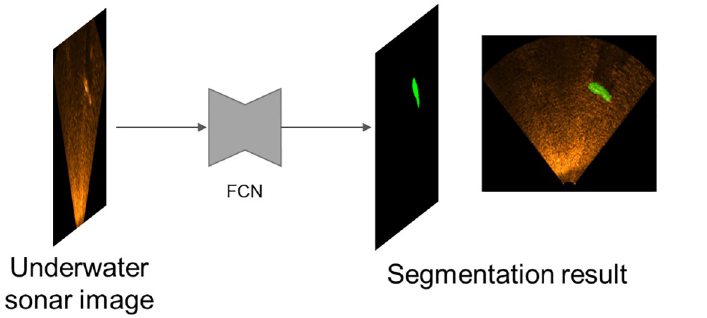
Fig 3. USI segmentation using a fully convolutional neural